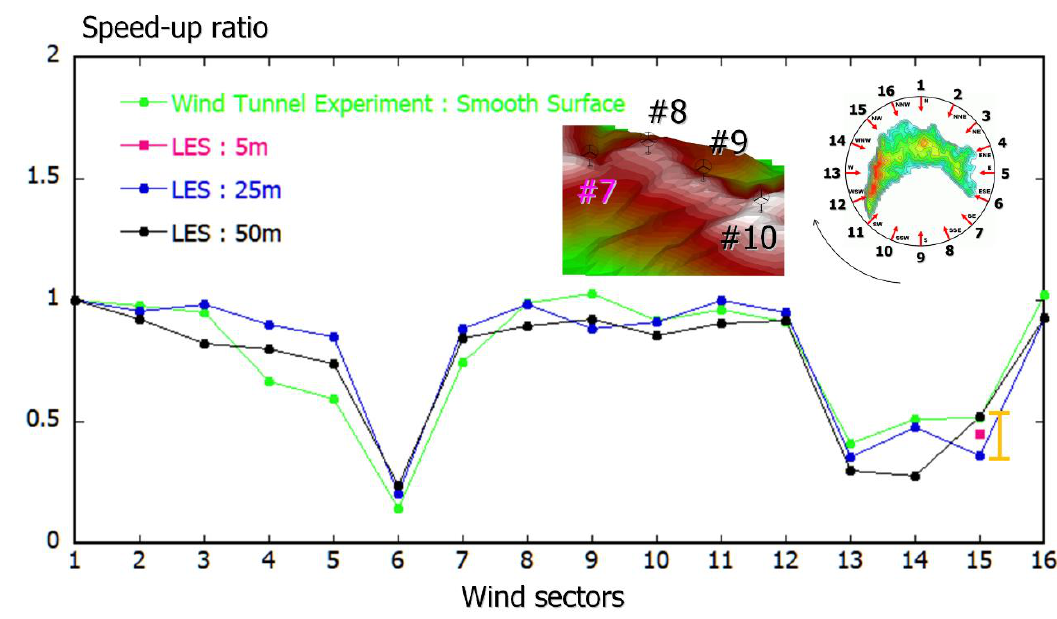
Figure 35. Comparison of local speed-up ratios at WT #7 hub height obtained by wind tunnel experiments and numerical simulations for 16 wind sectors.